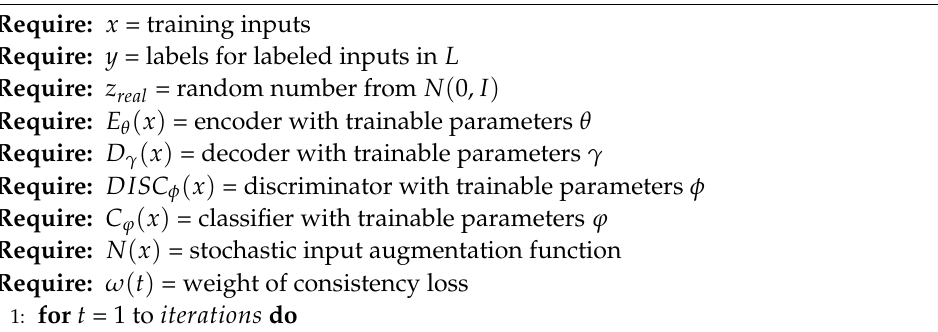
Algorithm 1 Mini-batch training of SSAE